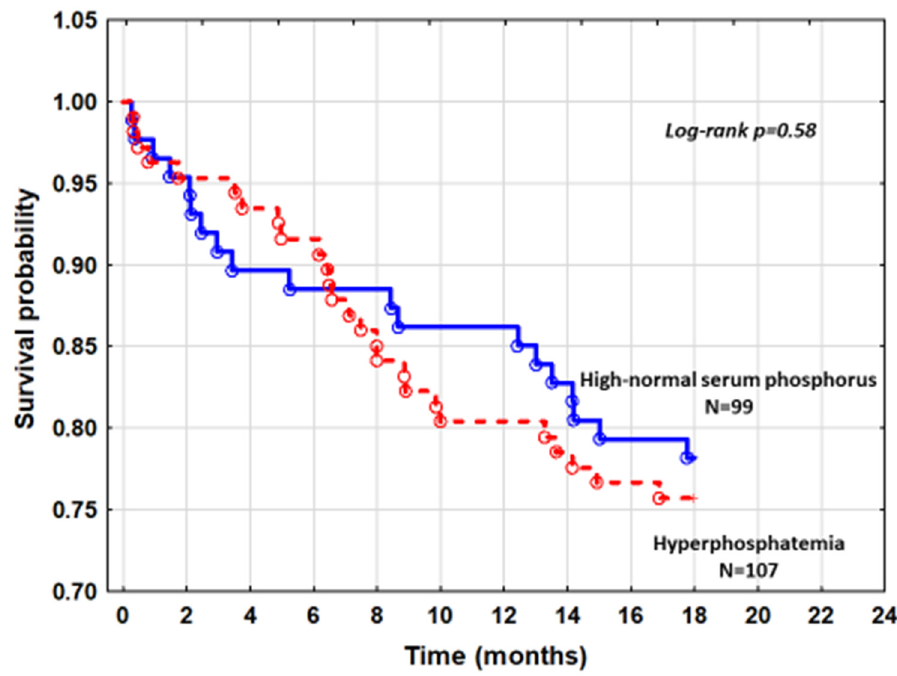
Figure 3. The cumulative survival curves comparing patients with hyperphosphatemia and patients with high-normal SP.